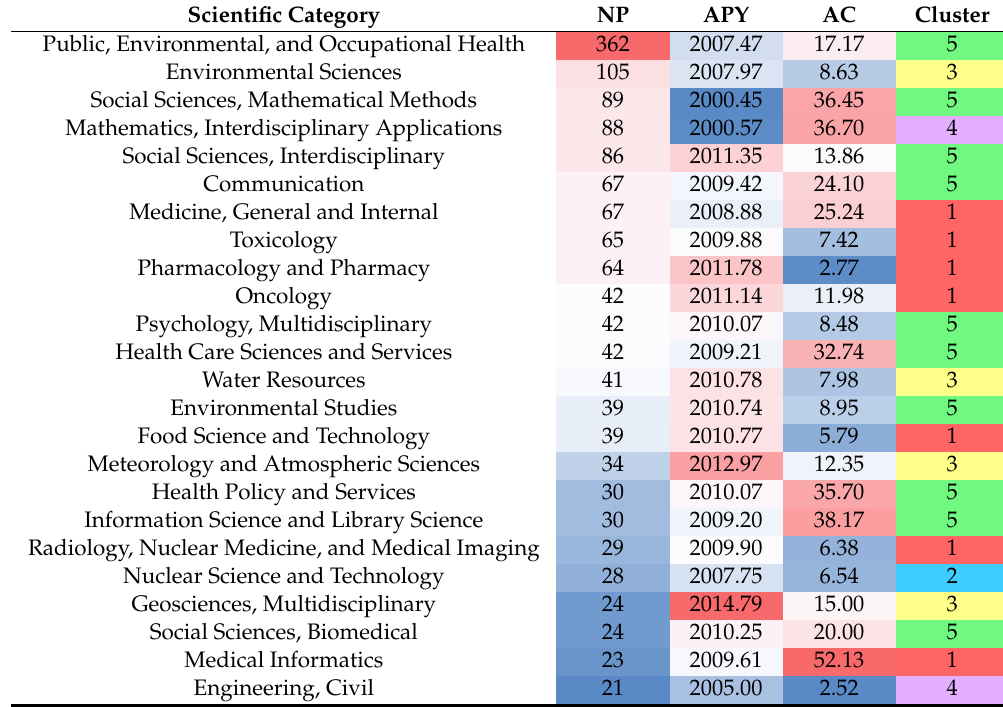
Table 4. Scientific categories with more than 20 papers on risk communication published.